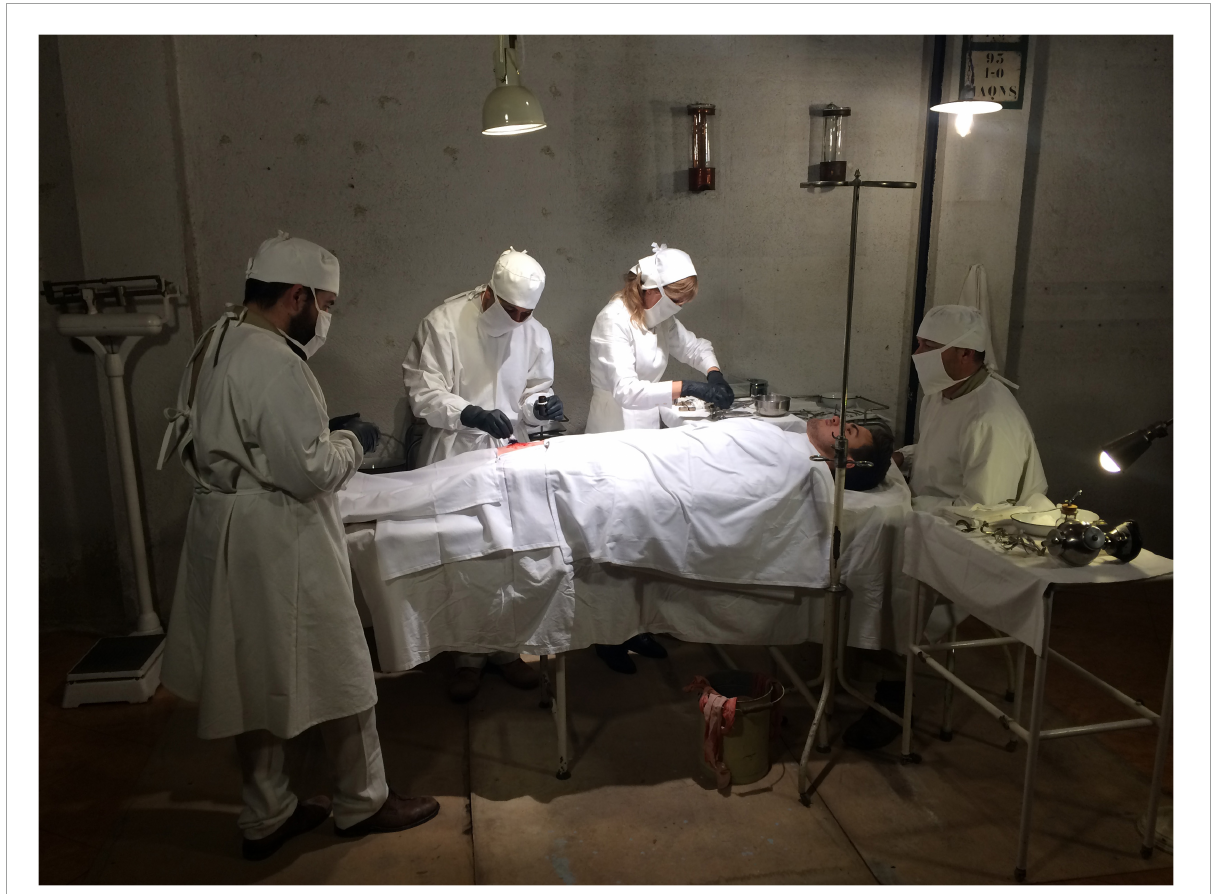
FIGURE4 Students of master’s studies in cultural and heritage management at the University of Barcelona in a film based on historical recreation for a hospital interpretation center during the Battle of the Ebro, during the Spanish Civil War. Recording set. Reproduction of surgical intervention. A surgeon, a nurse, a member of a recreation group, and two students from the University of Barcelona take